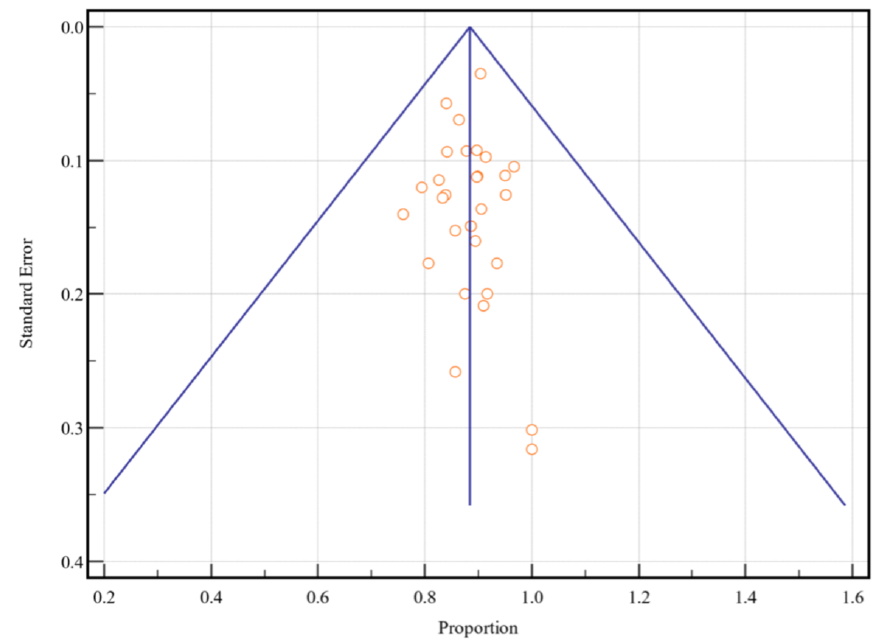
Figure 3. Meta-analysis of single means for participant pack years.